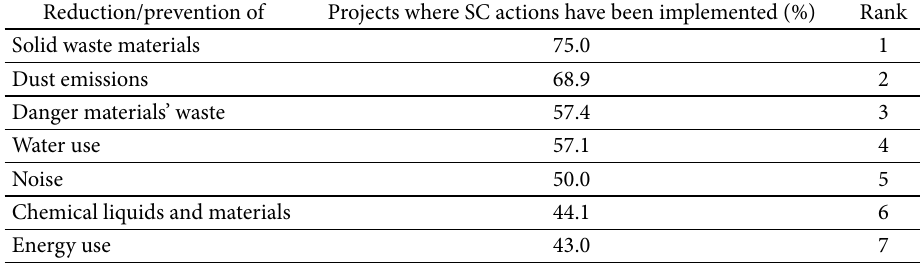
table 4. The percentage of projects where SC actions have been implemented on-site to reduce or prevent the environmental impacts of construction works reduction/prevention of projects where SC actions have been implemented (%) rank Solid waste materials 75.0 1 Dust emissions 68.9 2 Danger materials’ waste 57.4 3 Water use 57.1 4 Noise 50.0 5 Chemical liquids and materials 44.1 6 energy use 43.0